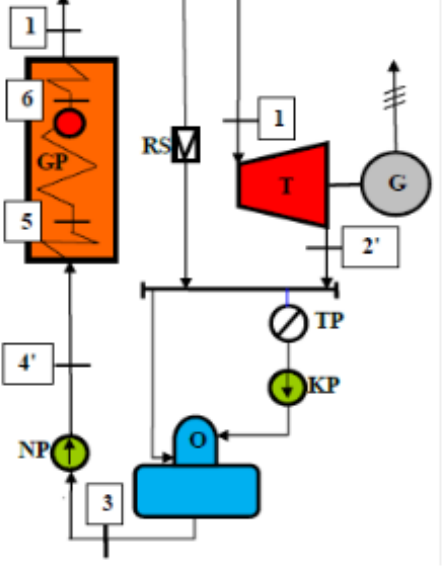
Fig.1. Steam turbine cogeneration